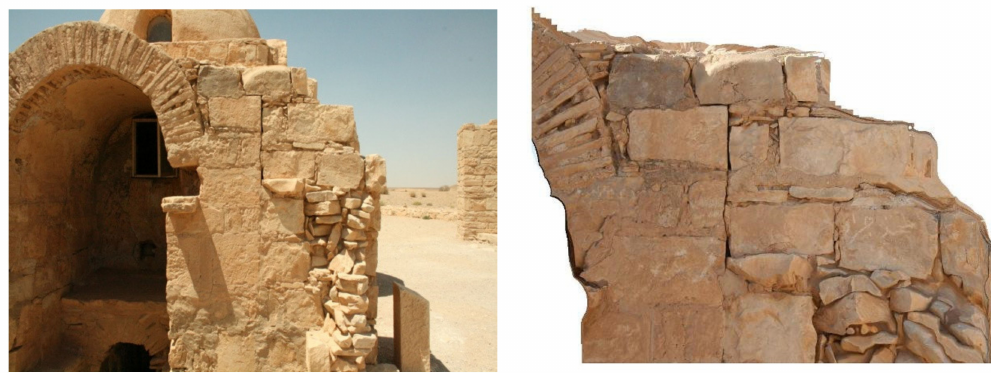
Figure 19. Di ff erential rectification can only produce satisfactory results for a flat part of the